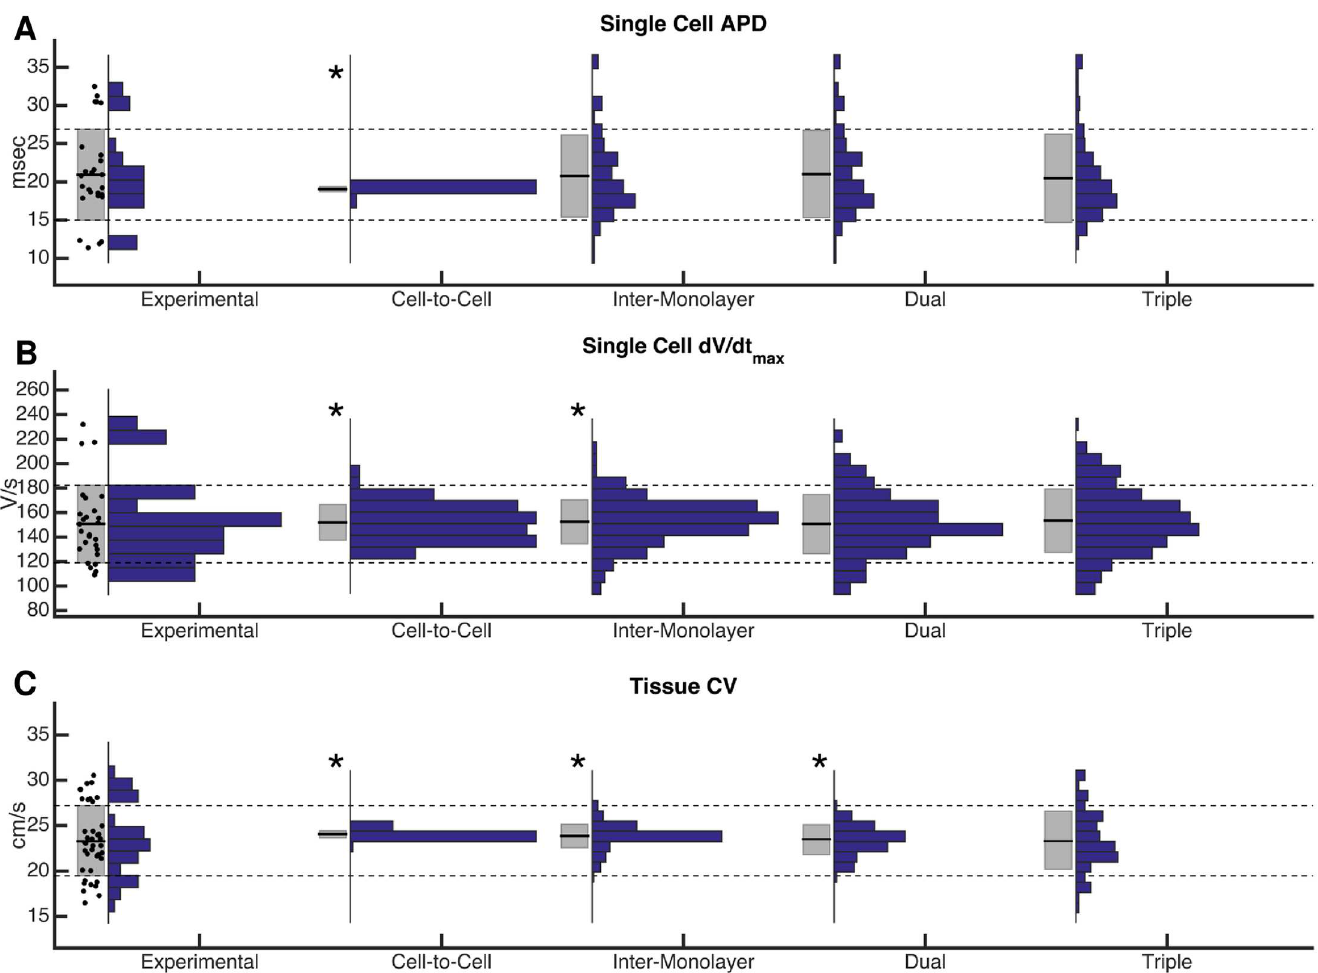
Fig 3. Comparison of methods of modeling variability. Modeling of cell-to-cell conductance variationand inter-monolayerconductance variation alone,or in combination (“dual variation”)is not sufficient to match all experimental variability. The additionof inter-monolayer bulk conductivityvariation (“triple variation”)allowedfor the replicationof experimentally observedvariabilityin singlecells (A and B), as well as in macroscopic conductionvelocity (C). Box plots to the left of each histogramindicate mean +/- one standarddeviation.Asterisks indicate that variancesare significantly different (p < 0.05) from experimental variability, using Levene’stest for equal